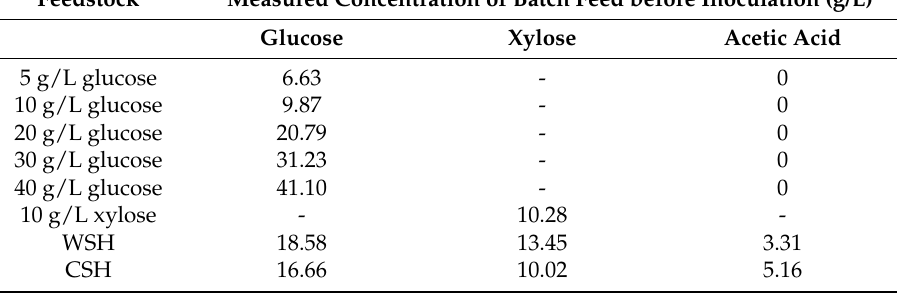
Table 1. Different concentrations of C6 (glucose), C5 (xylose) and lignocellulosic feedstock (WSH, CSH) sugars present in the batch experiments designed to test the growth of A. woodii . * All the experiments were performed in